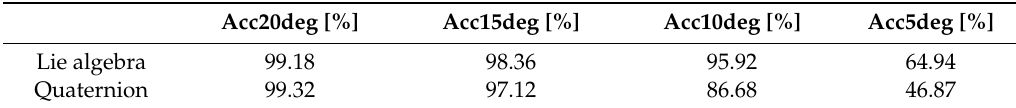
Table 2. Comparison of accuracies.